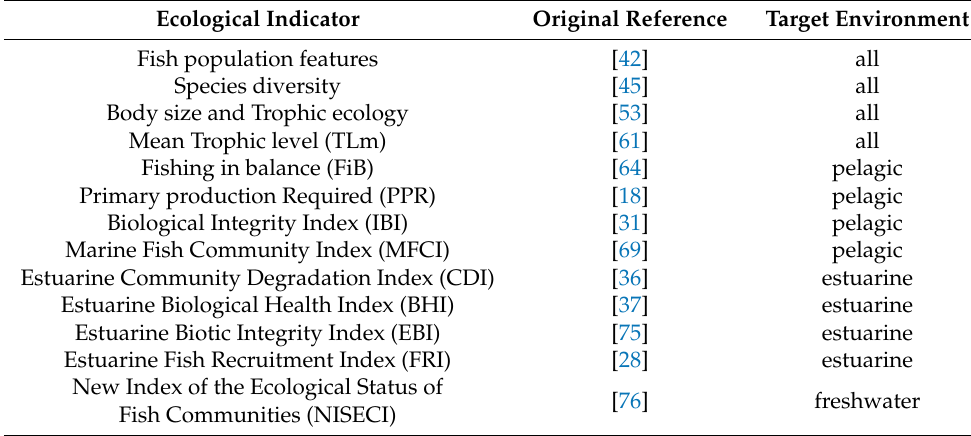
Table 5. Summary table of the main indicators considered, their respective original references, and target